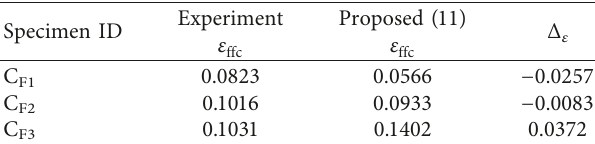
Table 7: Comparison of strains at failures between the proposed and experimental results.